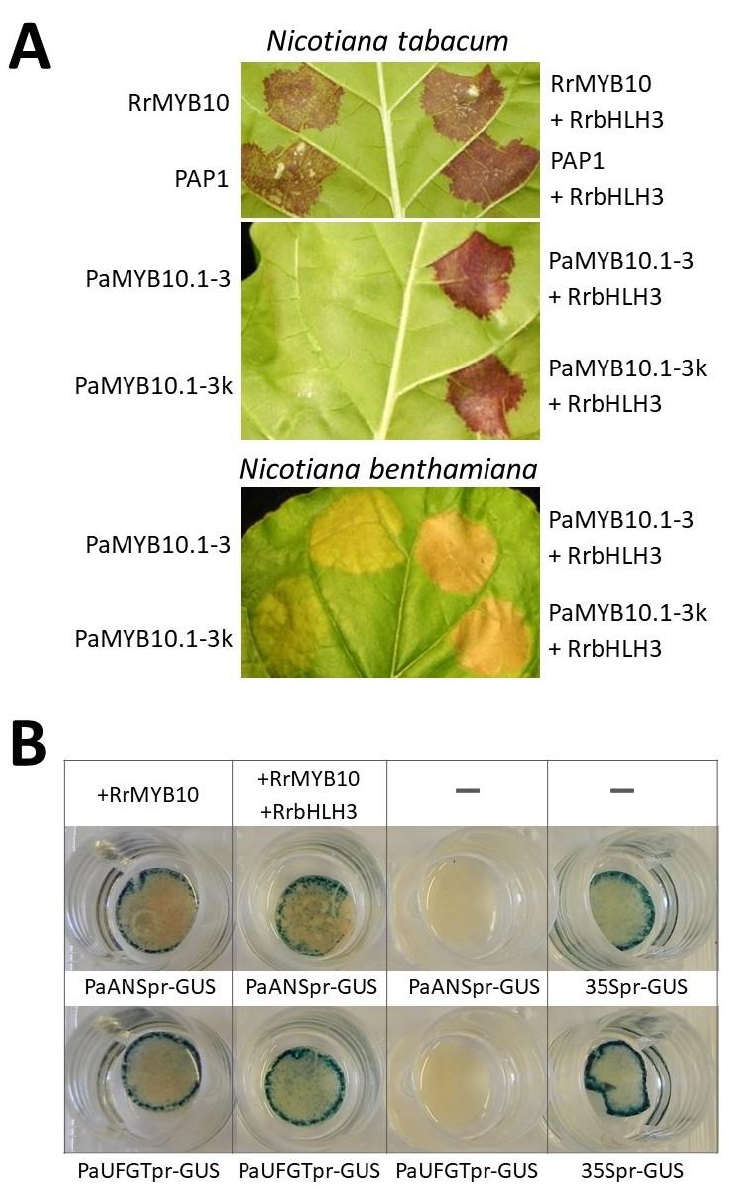
Figure 6. Transient expression of Ribes rubrum anthocyanin synthesis regulators in leaves of N. tabacum and N. benthamiana species. ( A ) The induction of anthocyanin synthesis by infiltrated regulatory genes. The comparison of the inducing capabilities of RrMYB10 and AtPAP1, and the effect of simultaneous infiltration of RrbHLH3 (top). The effect on the inducing capabilities of PaMYB10.1-3 elicited by the infiltration of RrbHLH3 in N. tabacum (middle) and N. benthamiana (bottom) leaves. PaMYB10.1-3k denotes an expression vector for cDNA of the PaMYB10.1-3 gene. ( B ) The reporter activation assay in N. tabacum leaves. GUS ( β -glucuronidase) expression cassette under the control of P. avium UFGT or ANS promoter was infiltrated together with RrMYB10 or both RrMYB10 and RrbHLH3. Single GUS expression cassette under the control of PaUFGT or PaANS promoter served as a negative control, whereas single GUS expression cassette under the control of cauliflower mosaic virus 35S promoter served as a positive control.